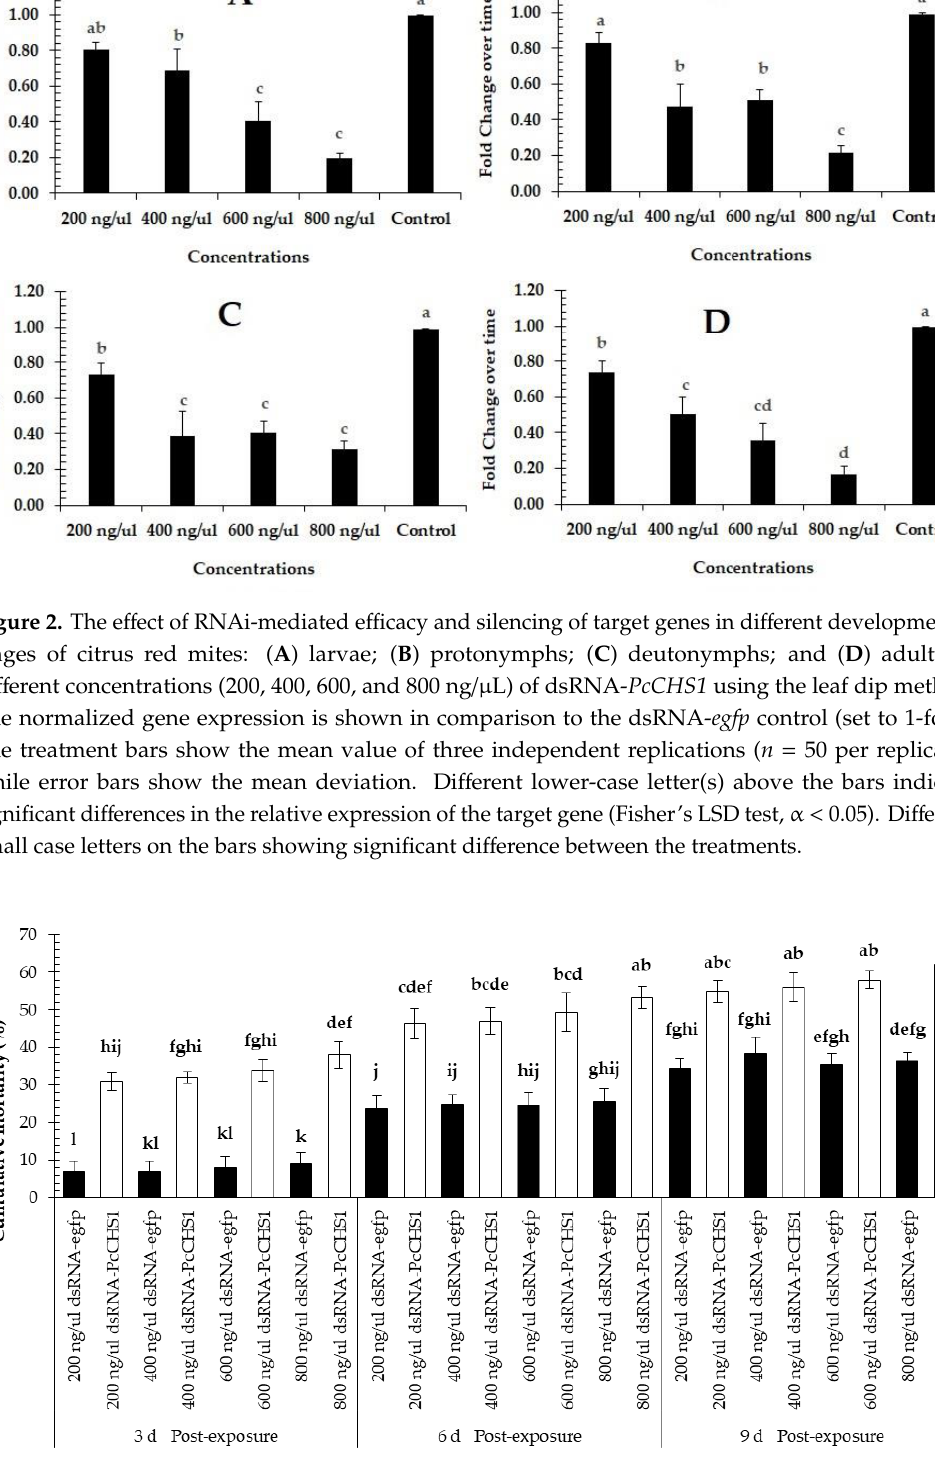
Figure 3. Time-mortality response of P. citri larvae upon exposure to the target gene ( PcCHS1 ), dsRNA- PcCHS1 , compared to the control group (dsRNA- egfp ). The values are the means of three independent replicates ( n = 50 per replicate). The mortality response over time was analyzed by a repeated measures ANOVA, and significant differences in the means were analyzed by a Fisher’s LSD test (α = 0.05). Different small case letters on the bars showing significant difference between the treatments.